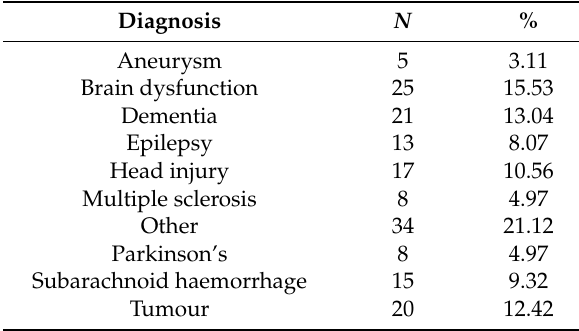
Table 1. Diagnoses Total Sample